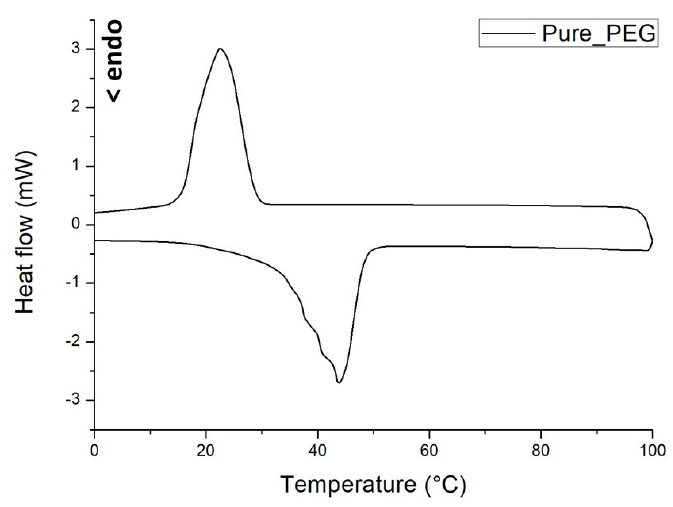
Figure 4. DSC thermograms recorded of pure PEG.